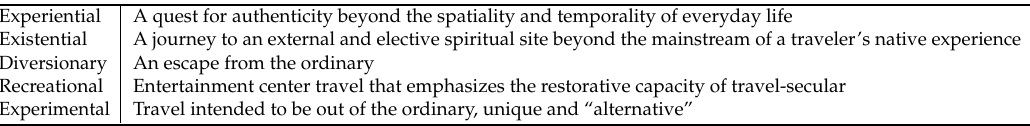
Table 1. Cohen’s modes of